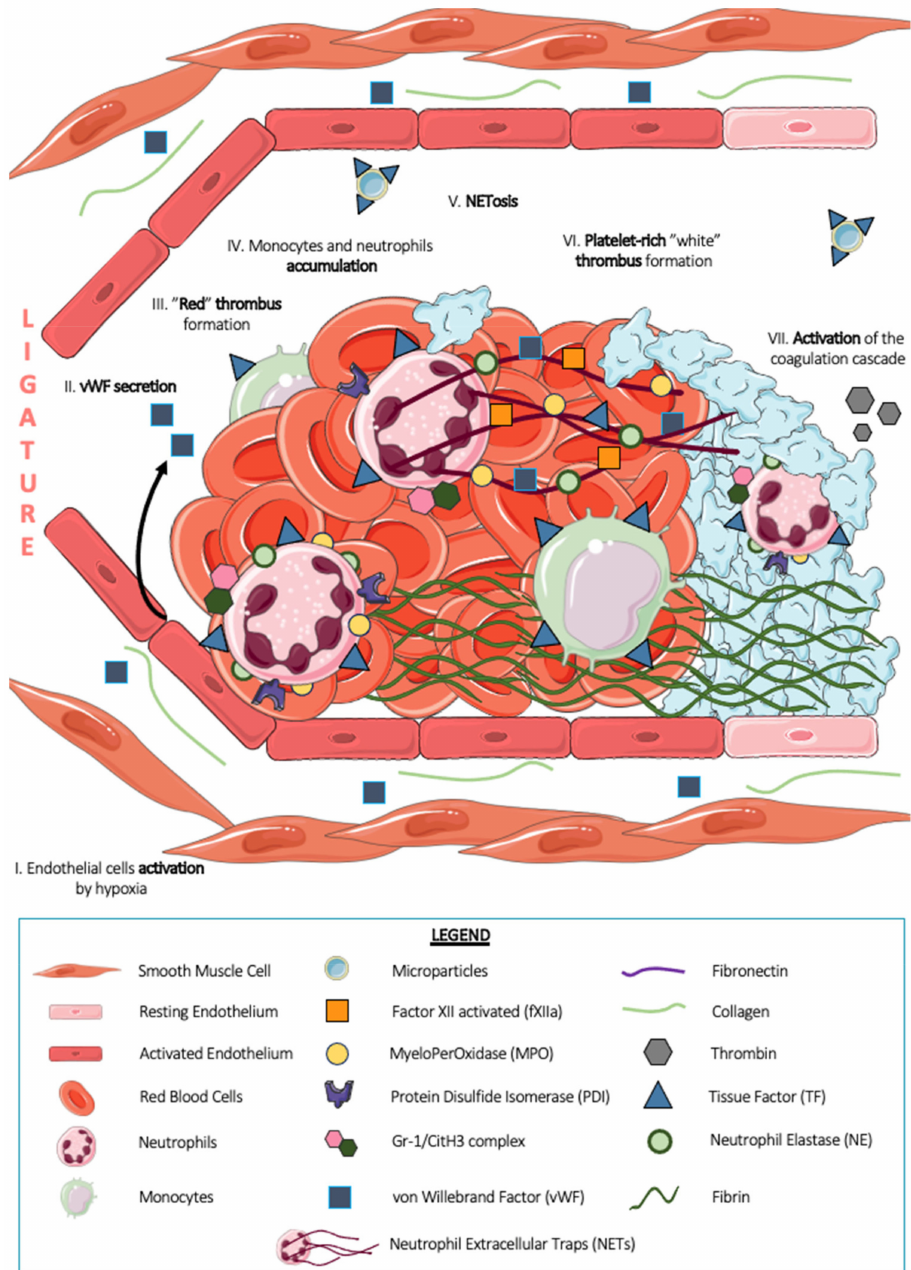
Figure 5. Thrombus formation after a ligature of the inferior vena cava (DVT model). Following a 90% flow restriction with a ligature of the inferior vena cava (IVC) in mice, the induced stenosis causes turbulences in blood flow and hypoxia of the cells, which together lead to local activation of the endothelium (I). This activation induces the release of von Willebrand factor initially contained in the Weibel–Palade bodies of endothelial cells (II). This pattern leads initially to the formation of a so-called “red” thrombus rich in erythrocytes (III). In this part of the thrombus, immune cells such as neutrophils and monocytes, as a majority, accumulate